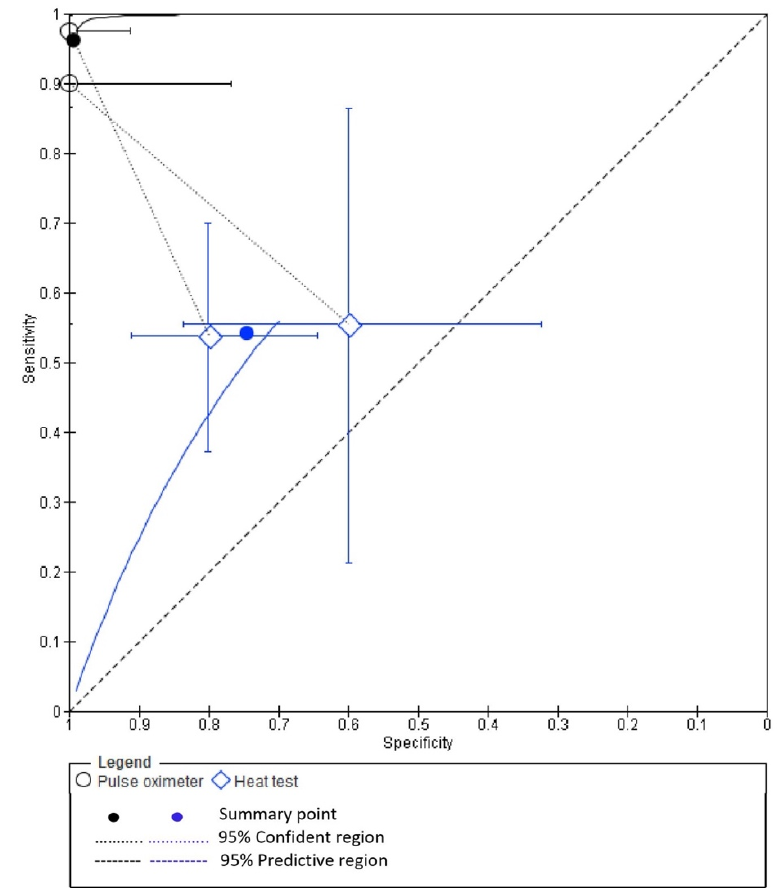
Figure 8. Bivariate meta-analysis pooled mean sensitivity with PO and HT.